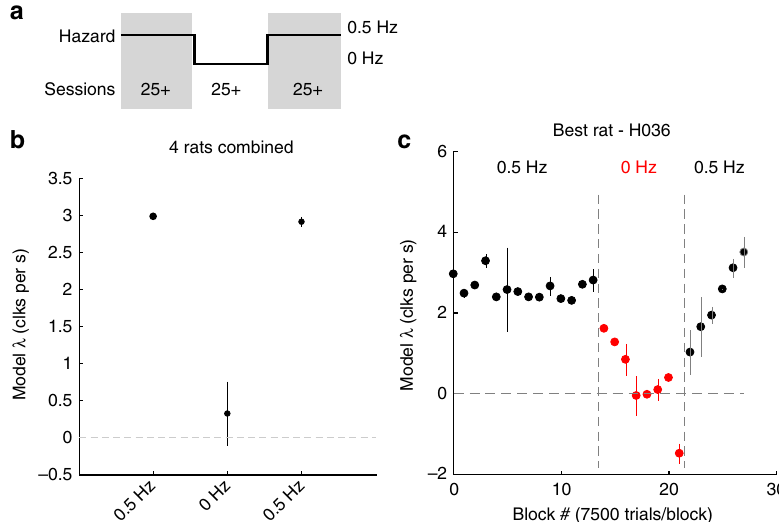
Fig. 6 Rats adapt to changing environmental conditions. a Schematic outlining the experimental design. Four rats were moved from a 0.5 Hz hazard rate to 0 Hz, then back to 0.5 Hz. Rats stayed in each environment for multiple daily training sessions, with a minimum of 25 sessions. b Quanti fi cation of evidence discounting rates before, during, and after the switch for the combined rat dataset using the trial-by-trial model. c Evidence discounting rate during the switch for one rat using the trial-by-trial model on consecutive blocks of 7500 trials. Only the evidence discounting term was fi t. b , c Error bars show 95% con fi dence